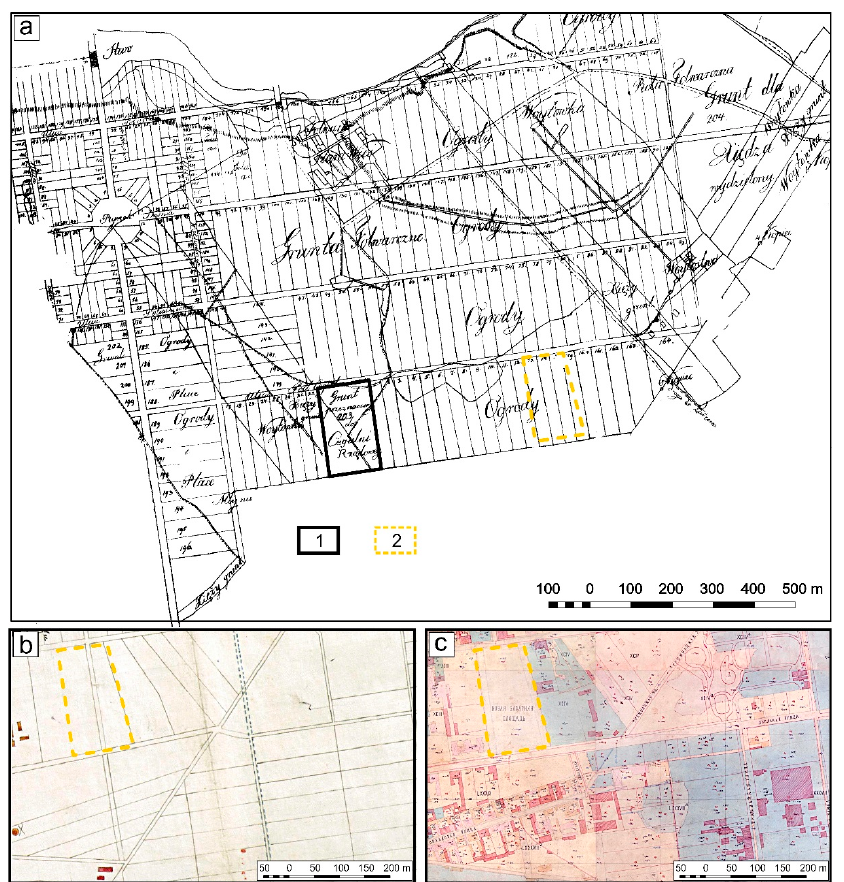
Figure 12. Changes in the relief of a fragment of the centre of Ł ód ź . ( a ) plan of the clothmakers’ settlement—Nowe Miasto by F. de Viebig from 1823, ( b ) vicinity of D ą browski Square on H. Majew- ski’s plan (1889), ( c ) vicinity of D ą browski Square on Starzy ń ski’s plan (1897). 1—planned area of the Government Brickworks of 1823, 2—location of future D ą browski Square. Source: Own study based on https://atlas.ltn.lodz.pl/, accessed on 14 June 2022; http://www.historycz- nie.uni.lodz.pl/przestrzenny.htm, accessed on 14 June 2022.